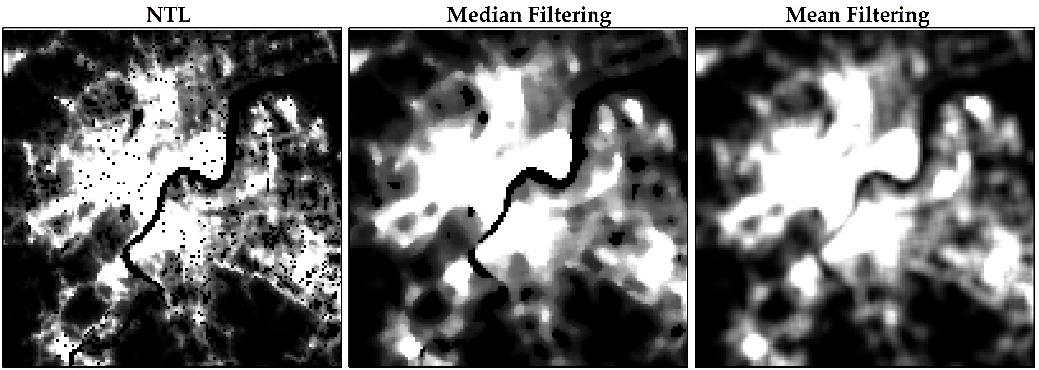
Figure 4. Comparison of NTL image filtering results: median filtering and mean filtering.